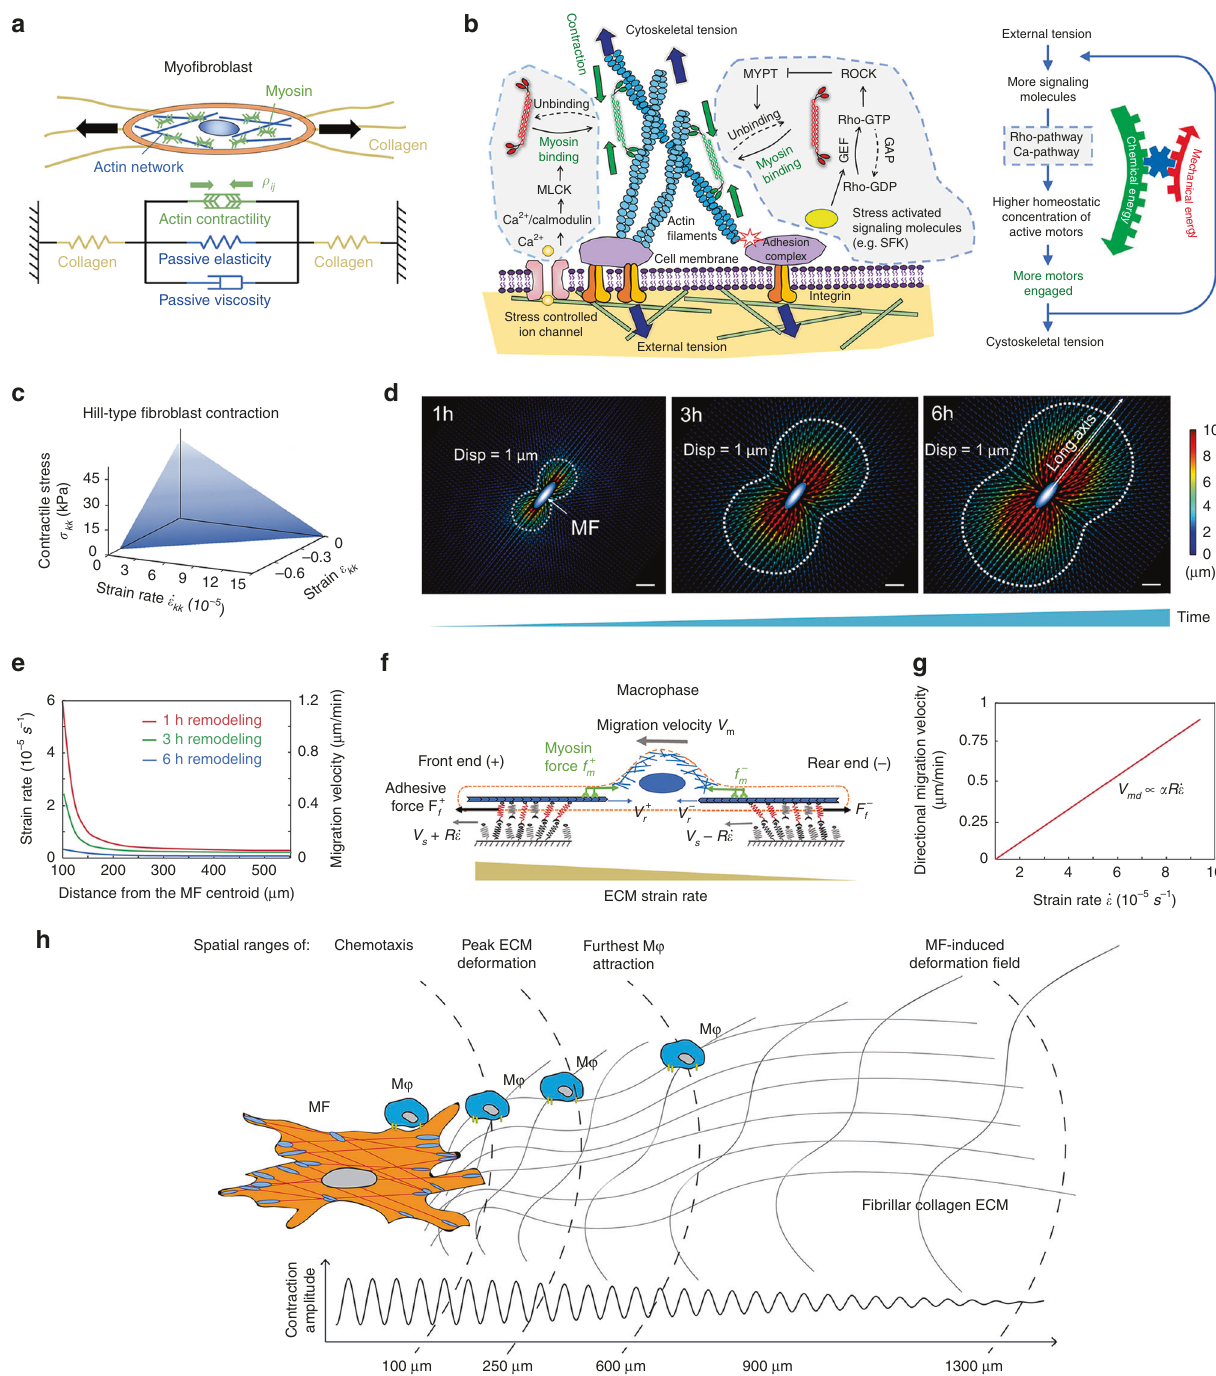
Fig. 9 Multi-scale computational model of myo fi broblast (MF) attraction by MF-induced collagen contractions. a Cellular-level model to obtain the spatiotemporal distribution of deformation fi elds created by MFs. b Schematic description of the cell contractility model. The Rho-ROCK and Ca 2 + pathways are regulated by the stresses from the extracellular matrix (ECM). When the cell is under tension, a series of biochemical process is activated, and ultimately, more myosin motors switch from inactive state (red) to active state (green) binding to the cytoskeleton, creating more force dipoles in the cell. Collectively, these force dipoles lead to contraction of the ECM. c The mechanochemical model adopts a Hill-type contractile behavior for the myo fi broblasts. d The predicted spatiotemporal variation of displacement fi elds in collagen. Scale bar: 100 μ m. e Strain rate and corresponding macrophage (M ϕ ) migration speed fi elds of the collagen substrate along the cell long axis shown in d as a function of distance. f Molecular-level model to determine the migration speed of the M ϕ . g The predicted linear relation between substrate strain rate and M ϕ migration ¼ α R _ ϵ . h The working model schematizes the attraction range of M ϕ in the experimental system in relation to literature values reporting speed V md chemotaxis ranges in similar open culture